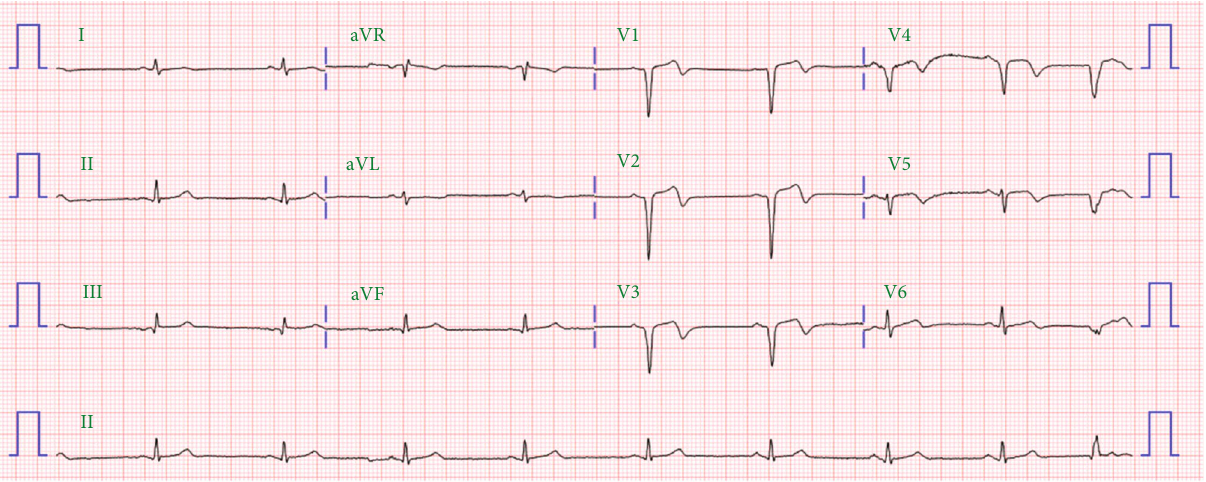
Figure 2: On the fourth day of hospital discharge, the ECG reveals no signi fi cant QT